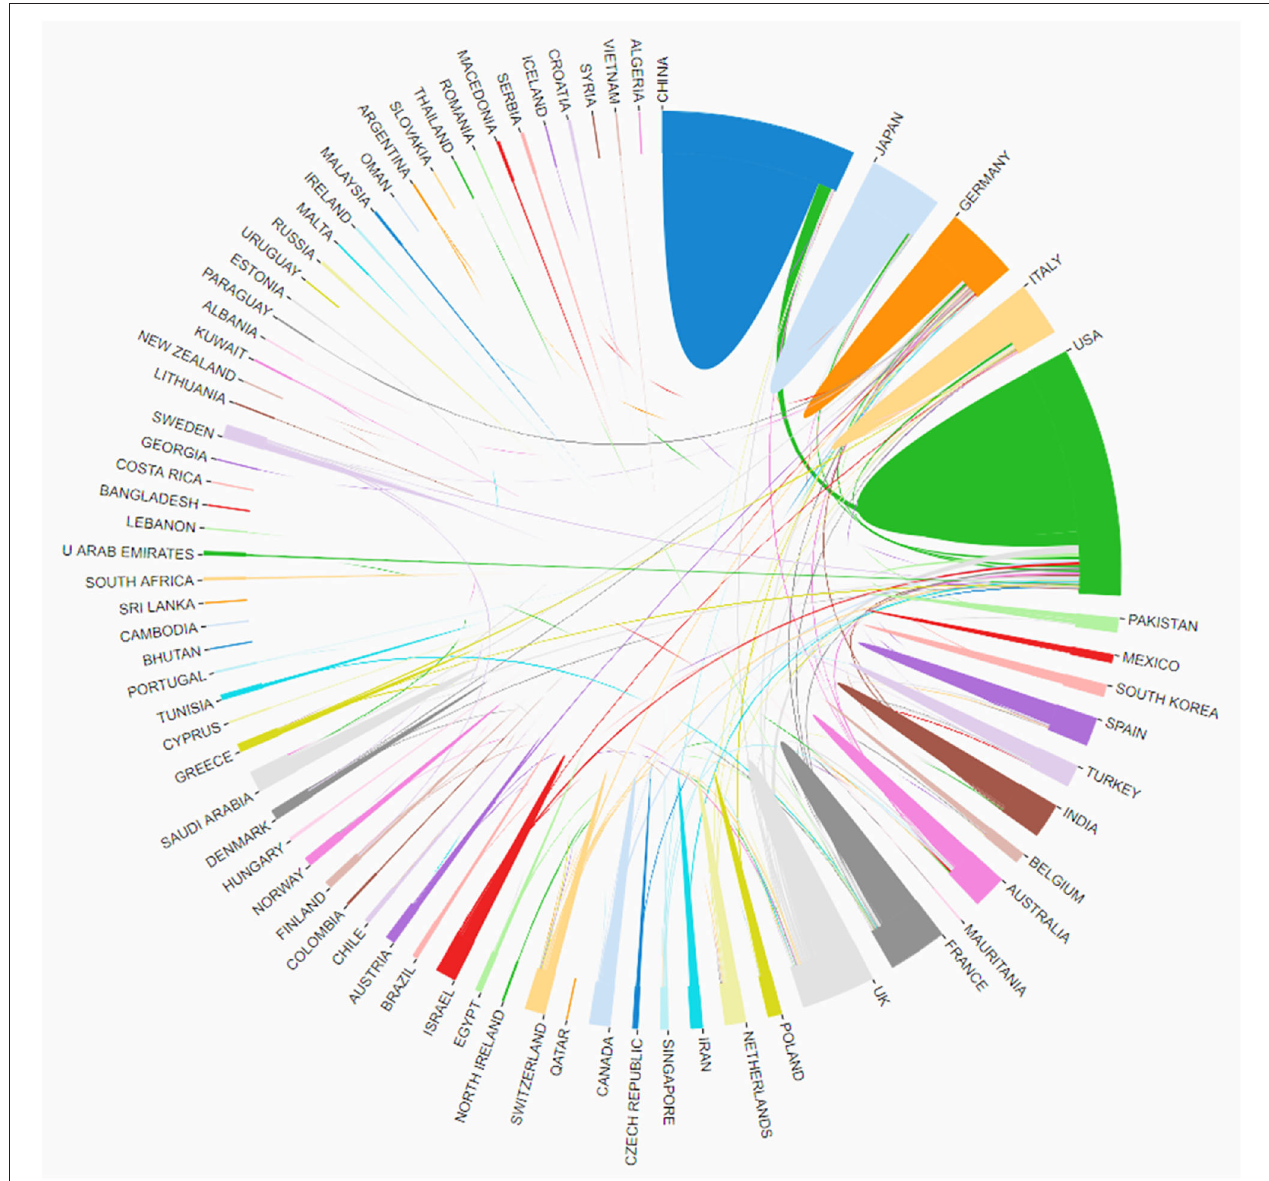
FIGURE 3 | The cooperation of countries/regions contributed to publications on Cataract-gene from 2010 to